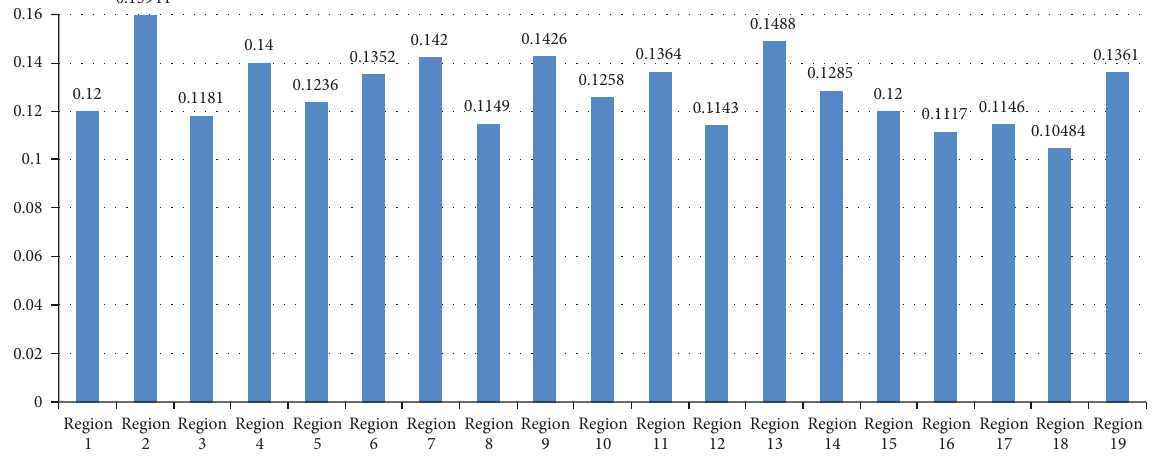
Figure 6: Overall priority of each of 19 districts of Qazvin city for the texture responsiveness criteria after the crisis and relief possibility.